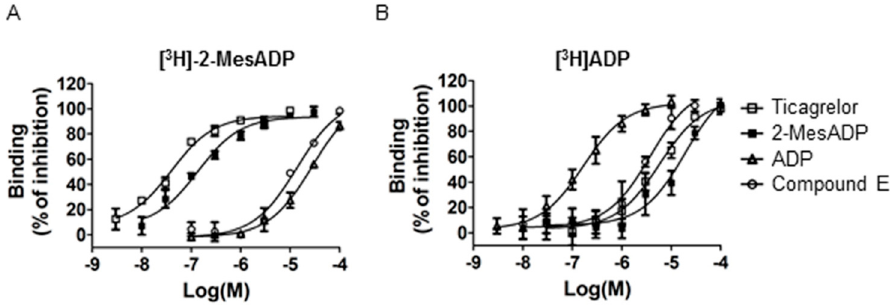
Figure 4. Comparison of pharmacological characteristics of Compound E and ticagrelor. Competitive